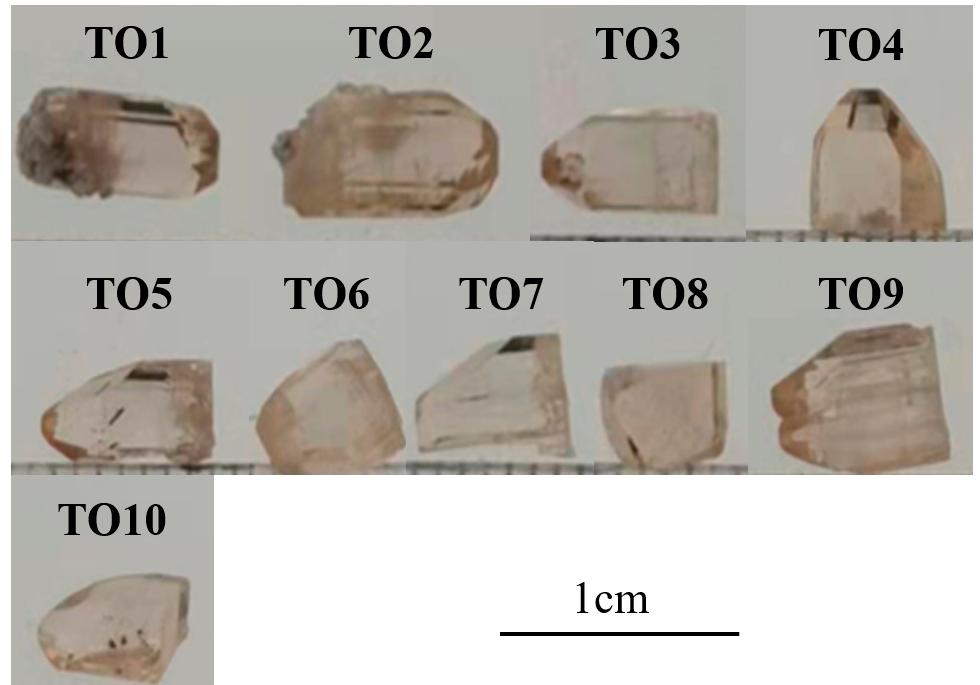
Figure 1. Photos of yellow topaz samples.